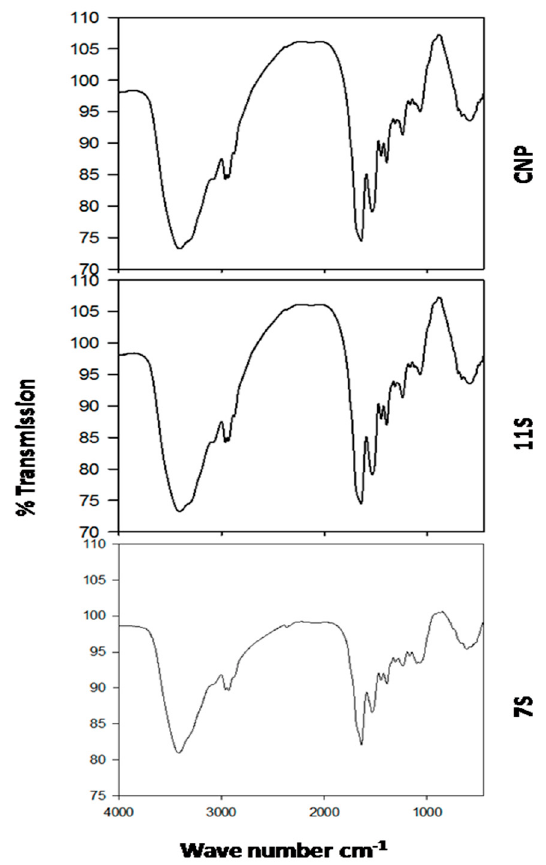
Figure 2. FT-IR different spectra of cowpea native protein (CNP), and its subunits; 11S and 7S globulins.